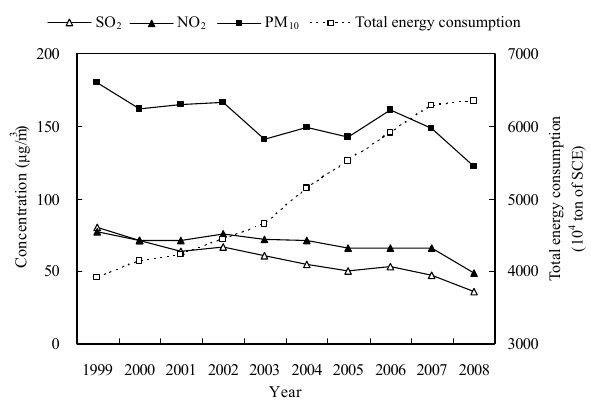
Figure 1. Annual variation of SO 2 , NO 2 , PM 10 and total energy consumption in Beijing during Fig. 1. Annual variation of SO 2 , NO 2 , PM 10 and total energy con- the last decade from 1999 to 2008. SCE is Standard Coal Equivalent. Data from the Beijing sumption in Beijing during the last decade from 1999 to 2008. SCE Environment Bulletin, 1999 to 2008. is Standard Coal Equivalent. Data from the Beijing